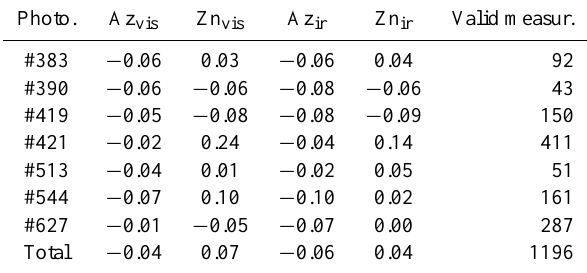
Table 5. Pointing error statistics for the 7 analyzed photometers in Table 6. Values of the field of view (in degrees) calculated during the azimuth (Az) and zenith (Zn) directions. The data are provided the preliminary tests using the sun as a light source. for the two physical channels, visible and infrared, in order to check also the parallelism between them. Photo. Photo.